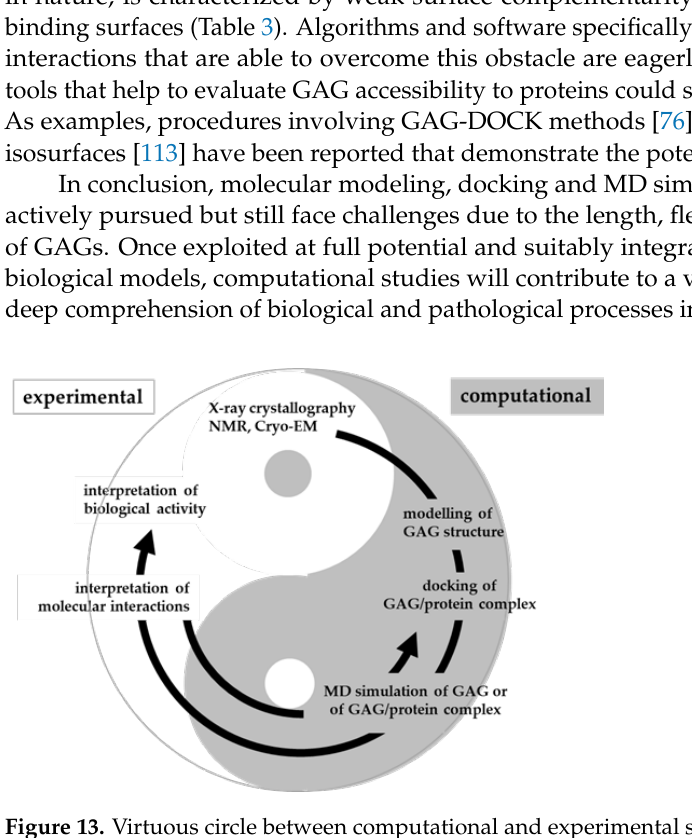
Figure 13. Virtuous circle between computational and experimental studies. As in the classical Yin and Yang principle, the two fields of research complement each other with the results from one pole helping the interpretation of the other. A correct balance between the two poles is needed in order to comprehend GAG/protein interactions and their biological consequences.